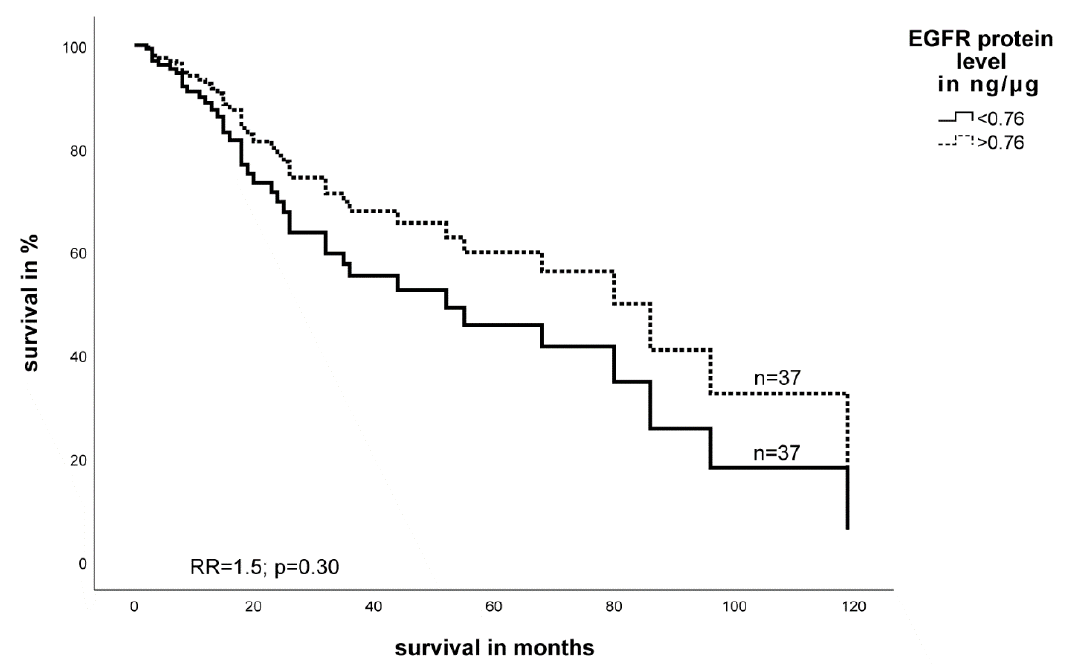
Figure 5. Multivariate Cox’s hazard regression model for EGFR protein expression and tumor-specific survival in STS patients. Expression of EGFR protein for 74 STS patients was associated with survival. The model was adjusted for tumor stage, tumor localization, tumor entity, and the type of tumor resection. The high and low cut-off values for EGFR were >0.76 and ≤0.76 ng EGFR protein per µg protein, respectively (RR = 1.5, p = 0.30).